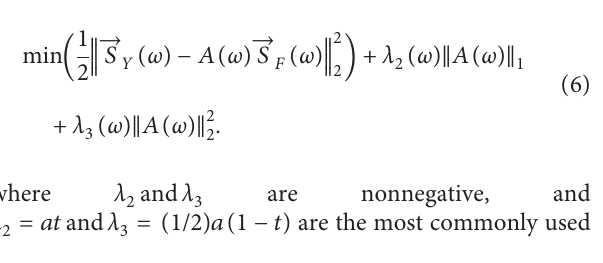
Figure 3: Schematic diagram of multivariate linear regression vibration response prediction model based on regularization